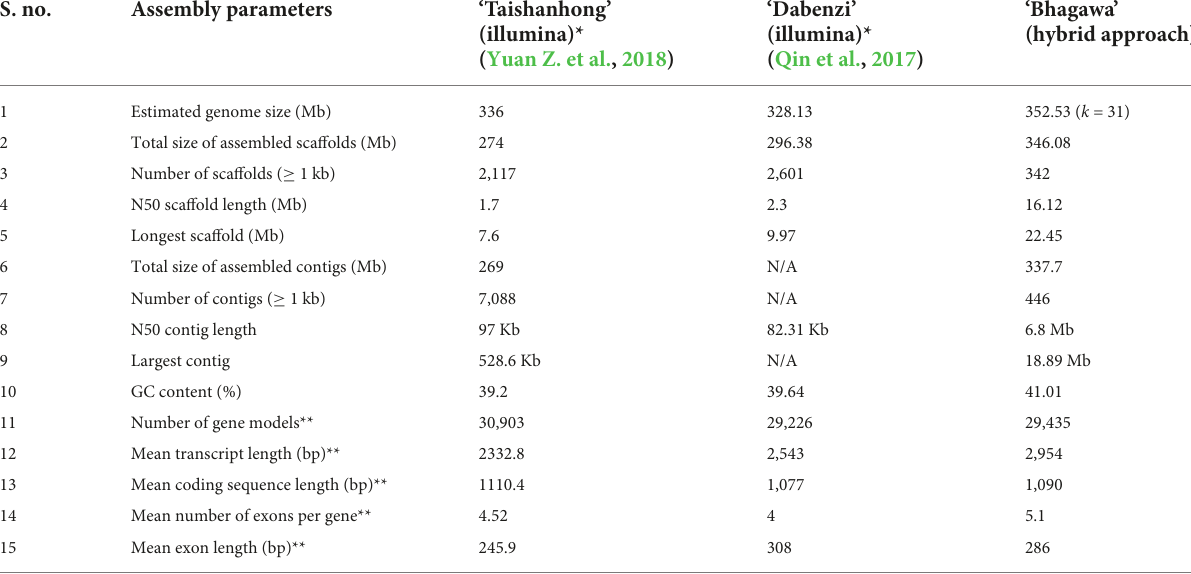
TABLE 3 Comparative metrics of the ‘Bhagawa’ genome with genomes of other pomegranate varieties available in National Center for Biotechnology Information (NCBI). S.